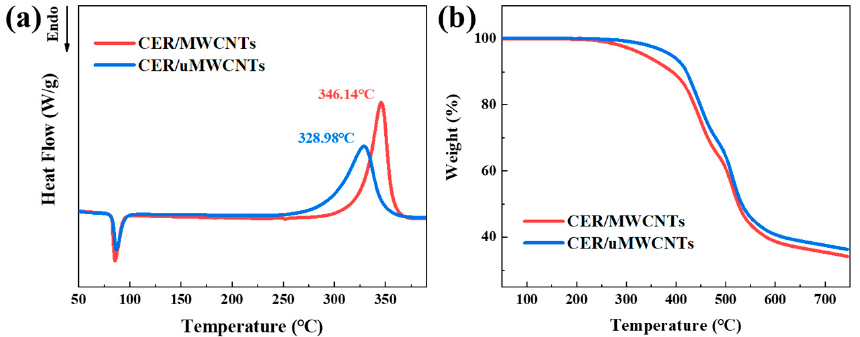
Figure 9. ( a ) DSC curves of polymerization of initial compositions (indicated in the plot); and ( b ) TGA curves for the CER/MWCNTs and CER/uMWCNTs nanocomposites.